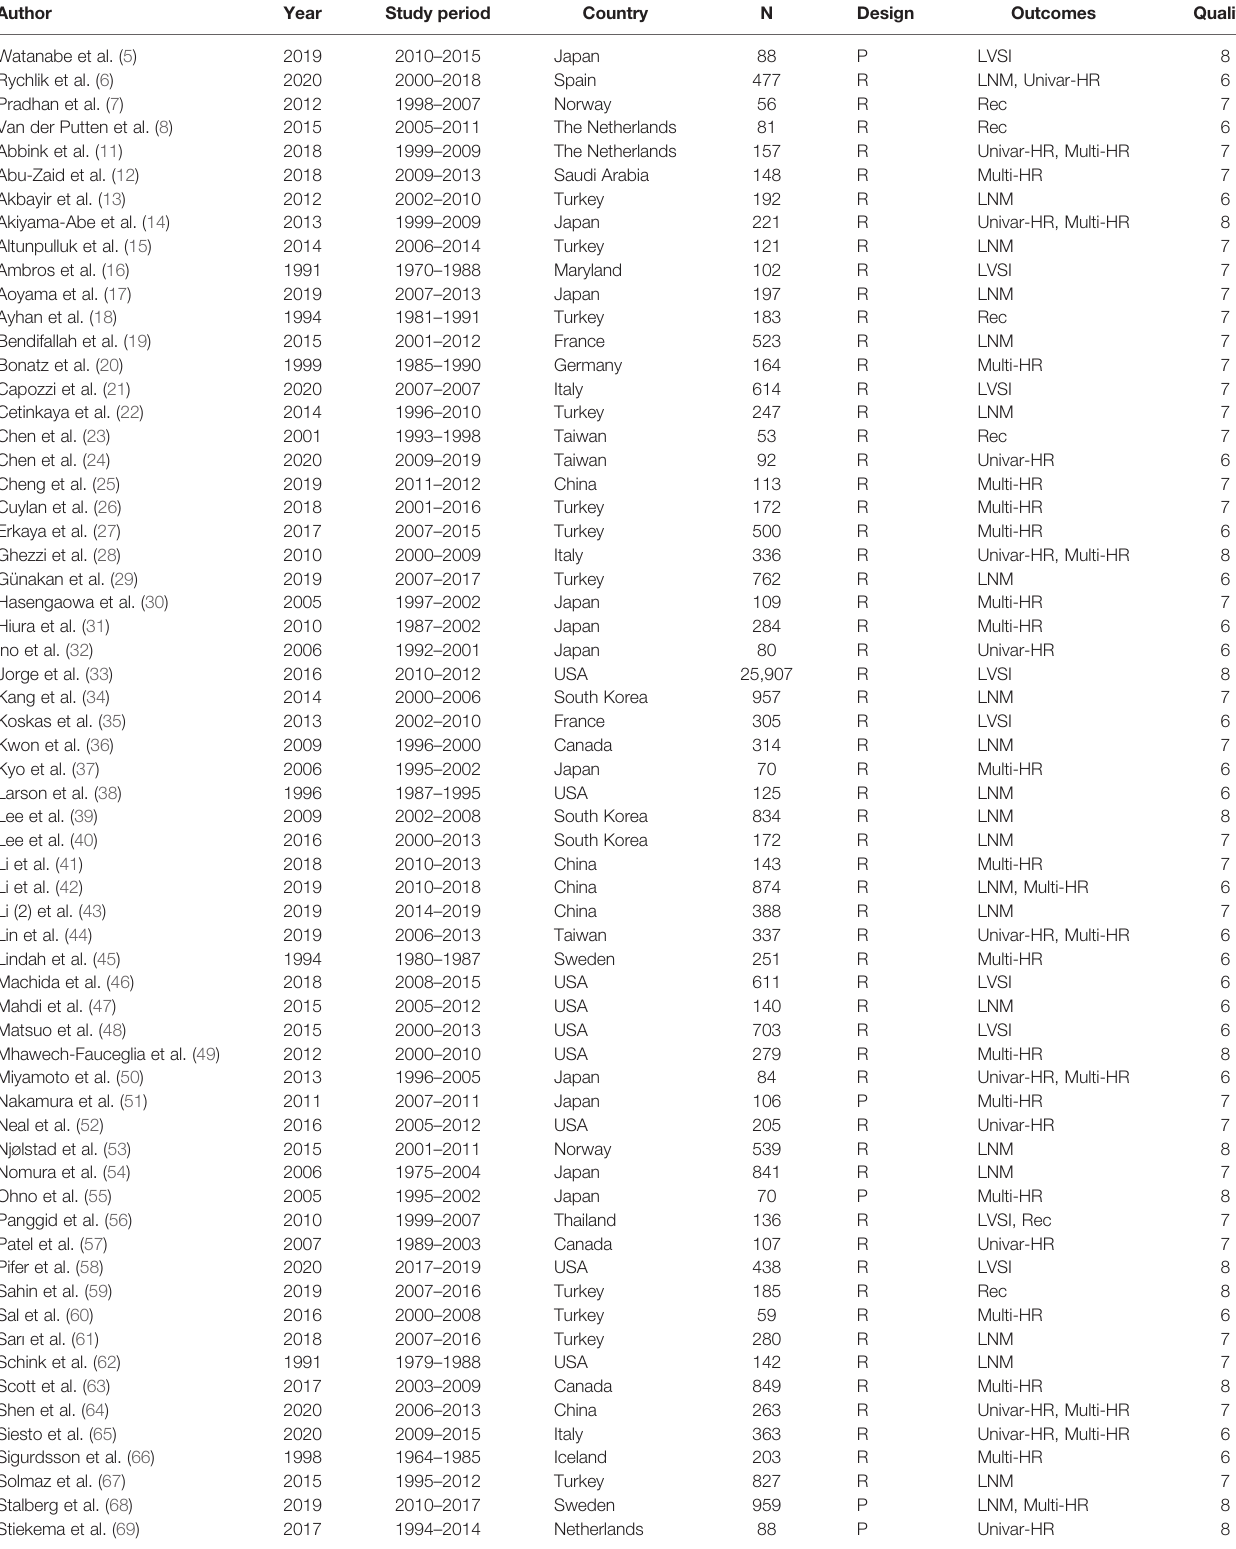
TABLE 1 | Baseline characteristics of included